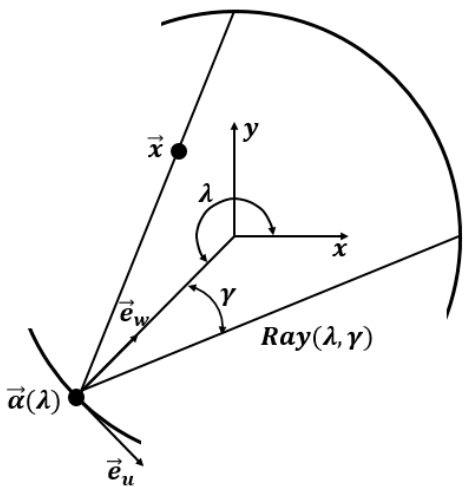
Figure 5. Fan-beam geometry based on the equiangular rays.